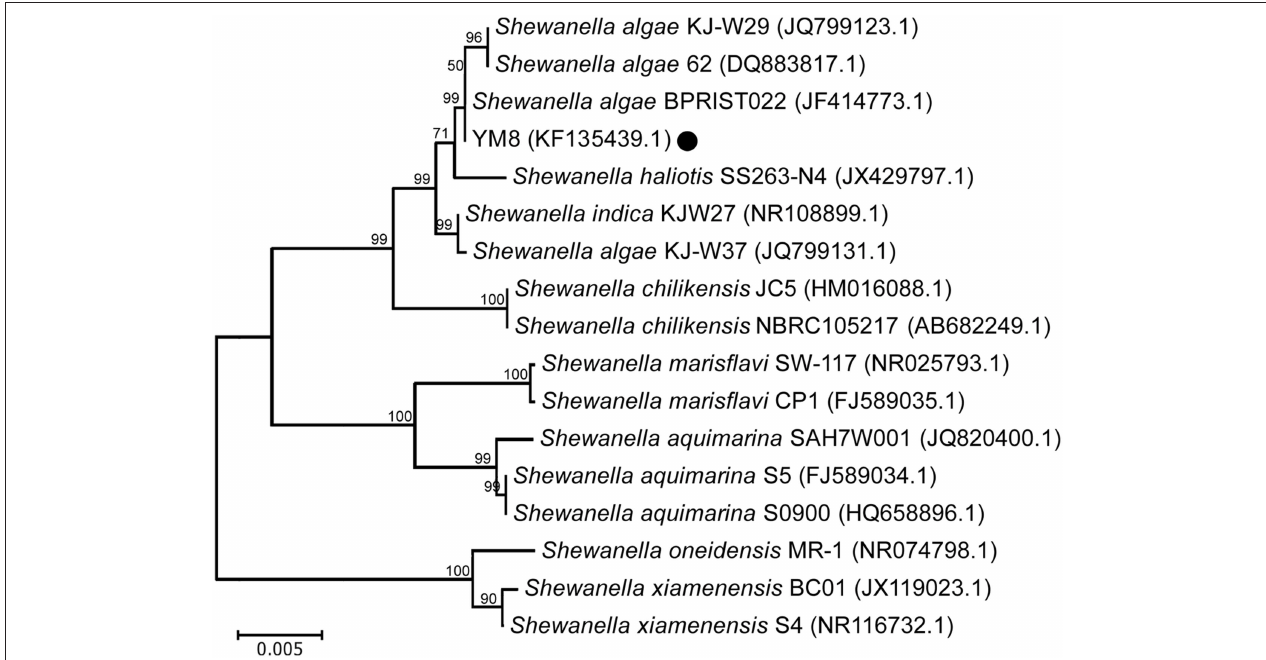
FIGURE 2 | Neighbor-joining phylogenetic tree based on 16S rDNA sequences of the YM8 strain and other Shewanella spp. retrieved from the NCBI database. The scale bar represents the number of substitutions per base position.